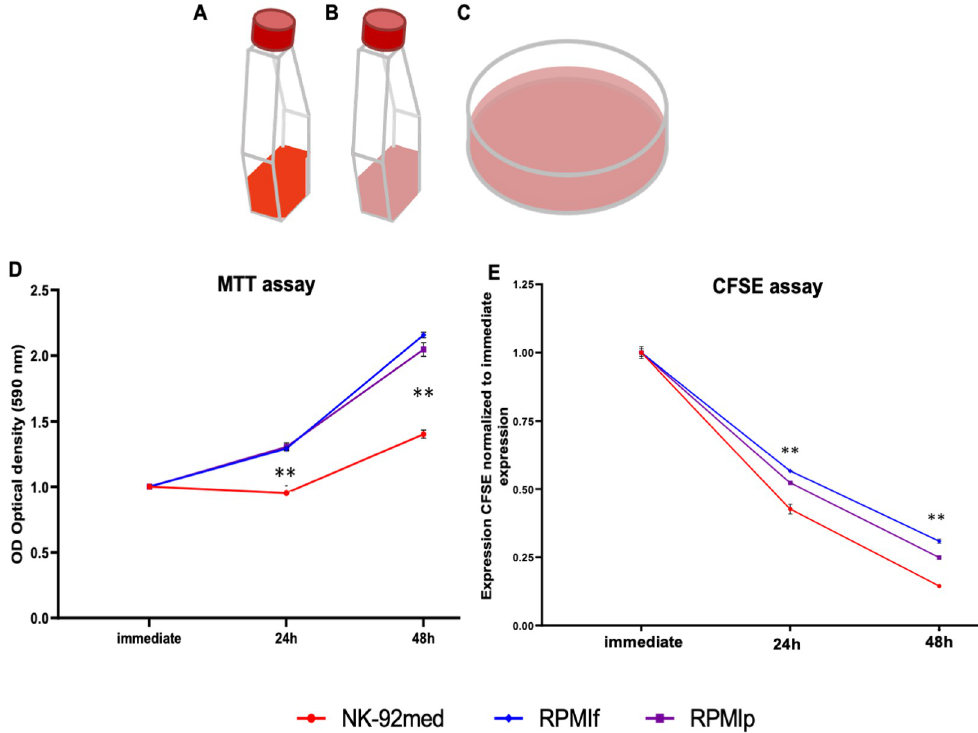
Fig 1. Schematic representation of the growth conditions and media of the NK-92 and growth progression in the media. A) Standing T25 flask containing the specialized NK-92 medium, which is in standard use ( NK-92med , medium represented in red); B) Standing T25 flask containing RPMI medium with added IL-2 (RPMIf, RPMI is represented in pink ); C) 10cm tissue culture dish containing the general RPMI-IL-2 medium ( RPMIp, RPMI is represented in pink ). D) MTT assay is shown over the course of 48h of incubation. Measurements are of optical density (OD) of a sample drawn at the indicated time after changing of medium. E) CFSE assay, as measured by FACS. Hours indicate time after addition of CFSE. Shown is the staining with CFSE normalized to the staining immediately upon addition of CFSE to the medium. D and E show 1 representative out of 3 assays performed. red = NK-92med ., blue = RPMIf , violet = RPMIp � p < 0.05, �� p < 0.005 compared between the NK-92 in NK-92 medium as control and the NK-92 in RPMI + IL-2 medium (two-tailed ANOVA test).